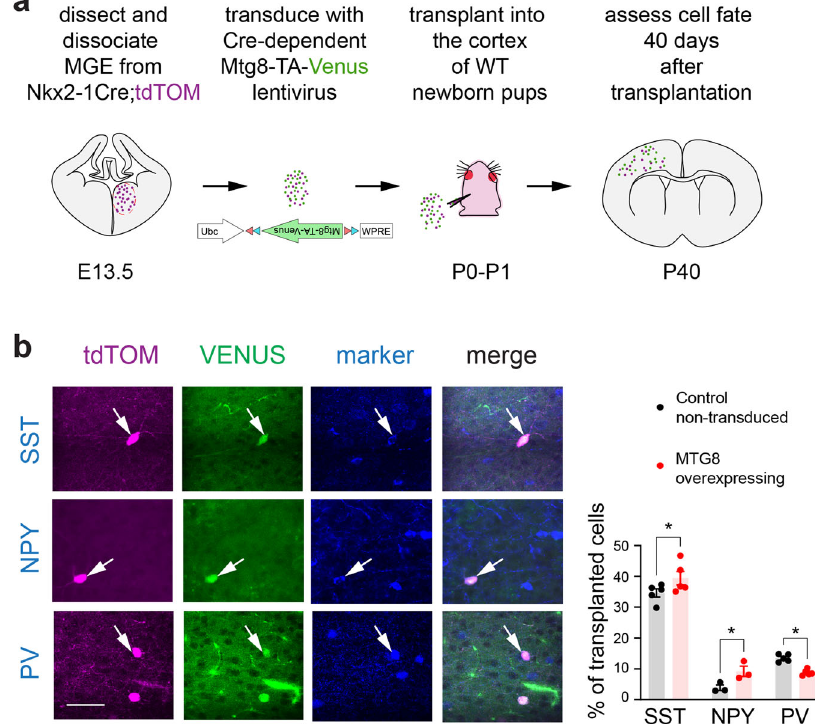
Fig.6|MTG8promotesSST-NPYfateintheMGElineage.a Experimentalscheme for overexpression of MTG8 in the MGE lineage by lentiviral transduction of dis- sociated MGE precursors, followed by transplantation into the cortex of newborn pups. Analysis was carried out in the somatosensory cortex 40 days post trans- plantation. b Immunohistochemistry and quanti fi cation for SST, NPY or PV toge- ther with tdTOM and VENUS to detect transplanted and/or transduced MGE